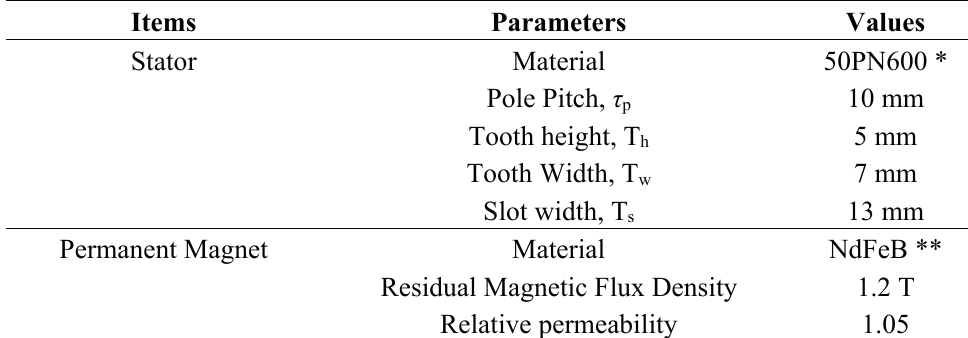
Figure 6. ( a ) Sensor module arrangement for position detection; ( b ) Experimental setup for the position measurement. Table 2. Specification of the experimental